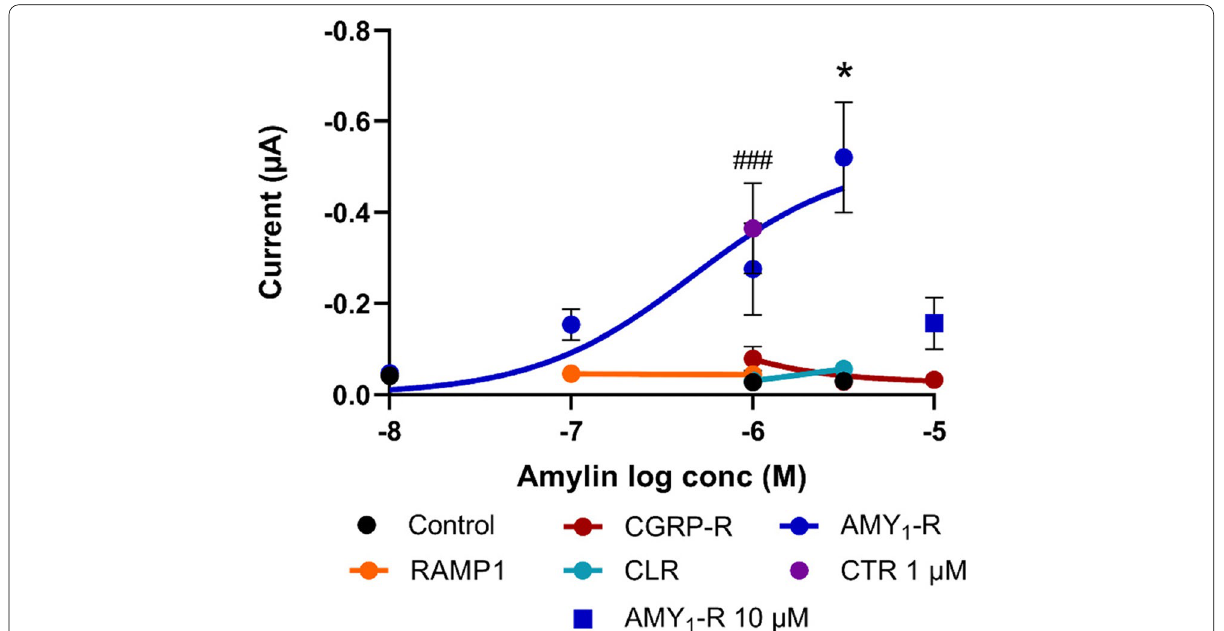
Fig. 4 Application of Amylin to Xenopus laevis oocytes expressing AMY 1 ‑R caused concentration‑dependent increase in current at a holding potential of 70 mV. In CTR expressing oocytes a significant response was obtained at 1 μM amylin. Amylin had no effect on oocytes expressing − CGRP‑R, RAMP1, CLR or non‑injected oocytes (control). Curves fittings by non‑linear regression curves using least square non‑lin fit of the c‑r relationship of log(agonist) vs. response (three parameters) were performed. The top and the bottom of the AMY 1 ‑R curve was constrained to the maximum response of amylin and zero, respectively. Furthermore, the response to 10 μM of amylin at the AMY 1 ‑R was not included in the calculation of the non‑linear regression curve. Statistical evaluation was performed by ordinary One‑way ANOVA followed by Dunnet’s multiple comparisons test on the response to the different concentrations of Amylin at one receptor at the time as compared to the 1 μM amylin response in non‑injected control oocytes* p < 0.05; ** p < 0.01. Mann Whitney test was used for the comparison of Amylin 1 μM on CTR, as compared to